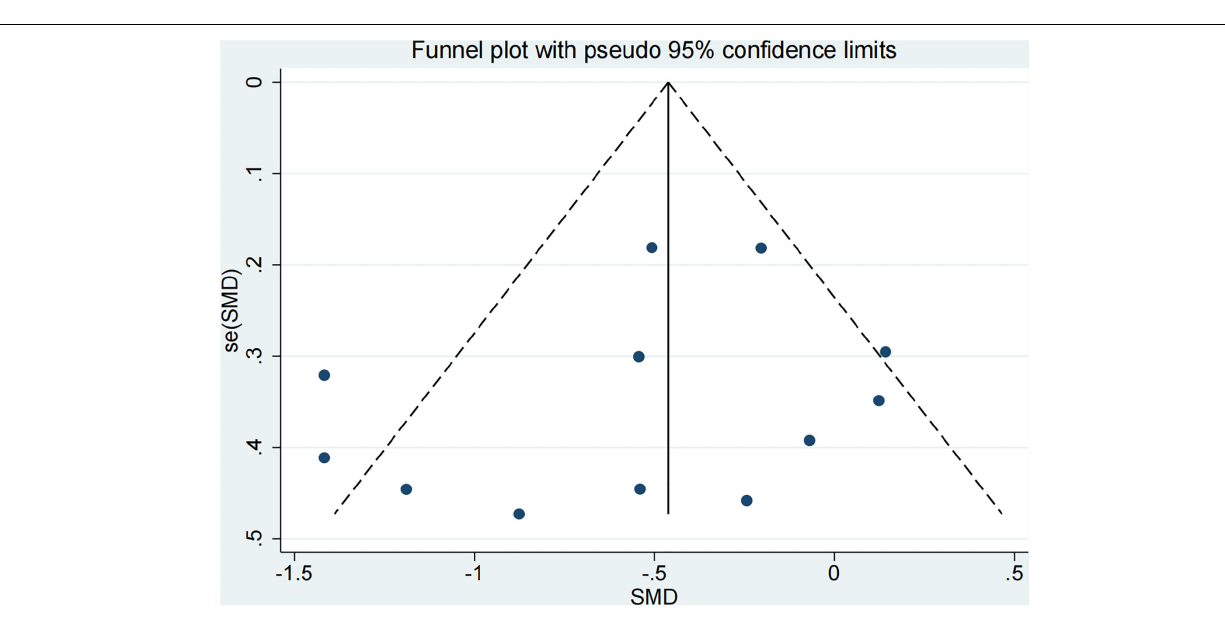
FIGURE 8 | Funnel plot for publication bias